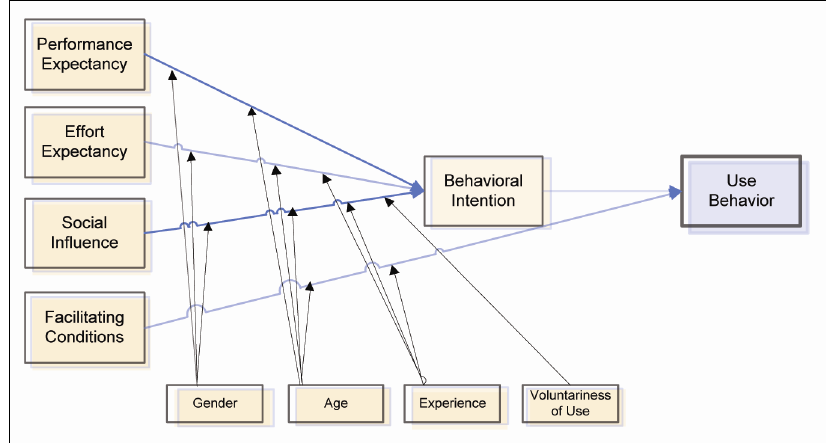
Fig. 6. The unified theory of acceptance and use of technology (UTAUT) model (Venkatesh et al.